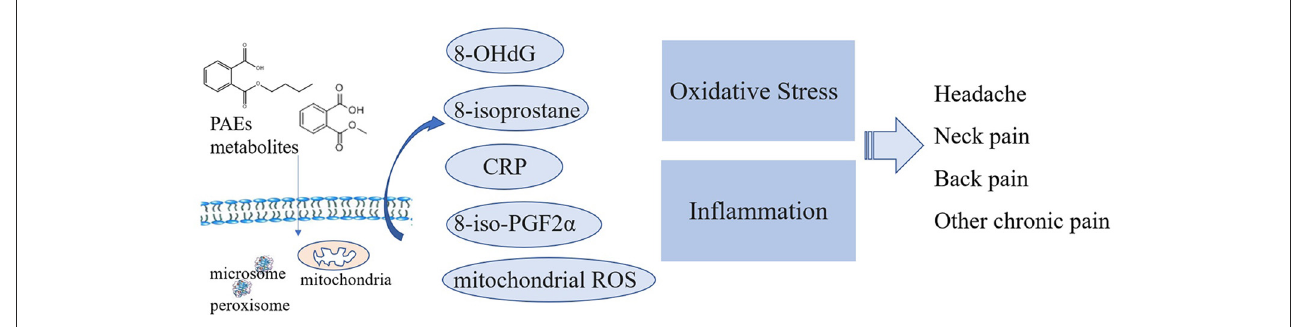
FIGURE4 Plausible molecular mechanisms of PAE